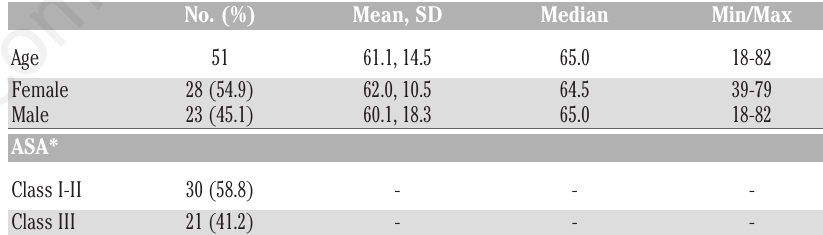
Table 1. Patient characteristics.